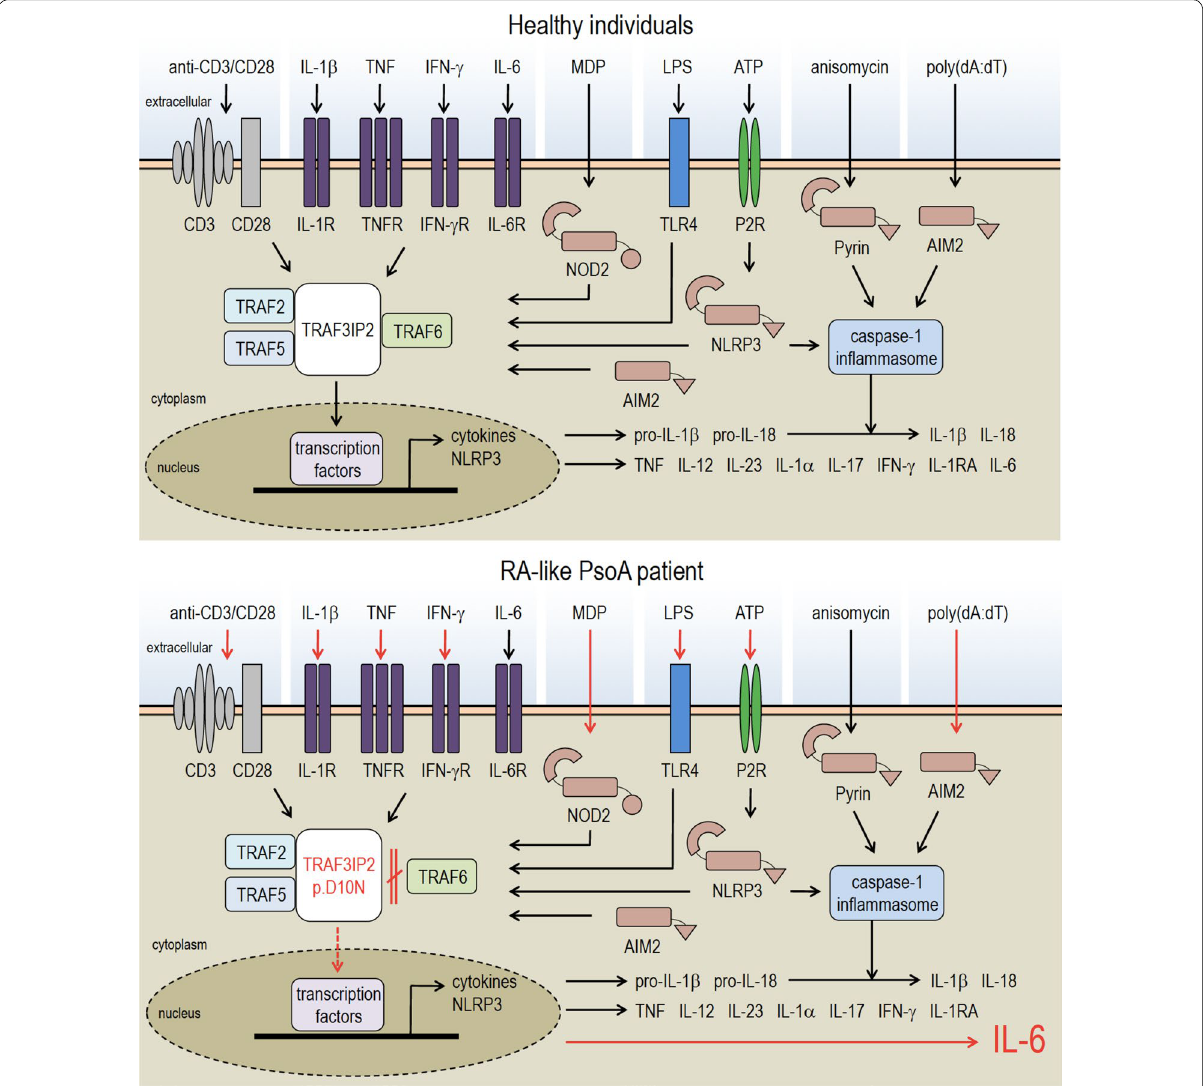
Fig. 3 IL‑6 production by blood leukocytes is altered in the RA‑like PsoA patient in response to immune activators. In healthy individuals (top panel), the stimulation of peripheral blood mononuclear cells with immune activators leads to the activation of intracellular multiprotein oligomers (e.g. inflammasomes) and specific receptors that activate signalling pathways, including TRAF proteins, translocation of transcription factors and subsequent cytokine response. In the patient with aggressive RA‑like PsoA (bottom panel), the activation of blood cells with anti‑CD3 pro‑inflammatory cytokines IL‑1β, TNF and IFN‑γ, muramyl dipeptide (MDP), lipopolysaccharide poly(deoxyadenylate–thymidylate) [poly(dA:dT)] led to a unique overproduction of IL‑6 (red arrows). As the patient is a heterozygous carrier for a single nucleotide polymorphism p.Asp10Asn (p.D10N) in TRAF3IP2 , this susceptibility allele causes altered TRAF6 binding (double red lines with an oblique stroke). The inhibition of the TRAF6 pathway could upregulate the TRAF2/5 pathway, leading to an enhanced immune response [21, 22] (dashed red